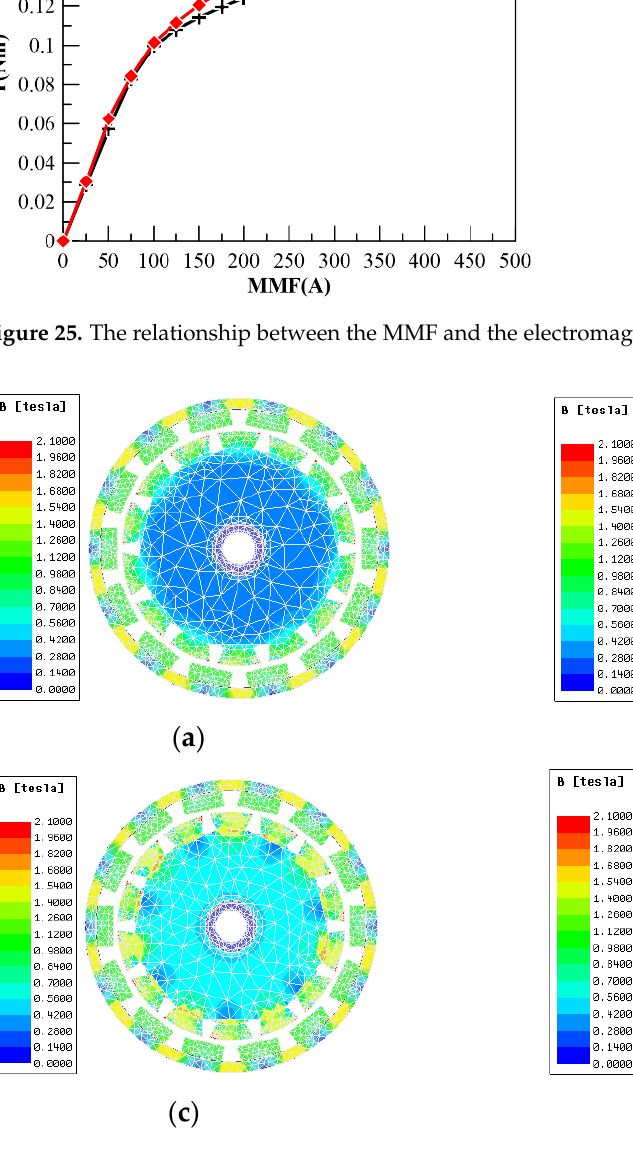
20 of 28 Figure 23. Angular displacement curve. The electromagnetic torque is a crucial index of the torque motor. Figure 24 gives the electromagnetic torque angle characteristic curve of CPMLTM. When measuring the elec- tromagnetic torque moment angle characteristic, the magnetic potential generated after the coil is energized is 100 A. It can be found that the difference between the experimental data and the simulation gradually increases with the increase of the turning angle, which is because the coaxiality between the torque sensor, the tension sensor, and the prototype cannot be guaranteed, so the error will be generated during the rotation. Figure 24. The electromagnetic torque angle characteristic curve of CPMLTM. When the rotor is in the neutral position, the relationship between the coil MMF and the electromagnetic torque is shown in Figure 25. It can be seen that the experimental